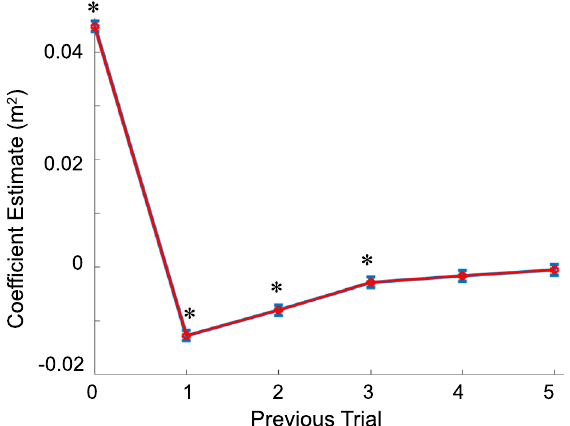
Figure 5. Trial-by-trial analysis Results of a linear regression model between force field direction and COM signed deviation. Variable coefficient estimates are on the y-axis and variable number representing previous trial number are listed on the x-axis. Error is shown as mean ± SD. Significance from zero ( p < 0.05) is denoted by ( ✽ ). These results suggest that when a given force field trial was implemented this caused error in that direction. On previous trials there was compensation in the opposite direction of the initial